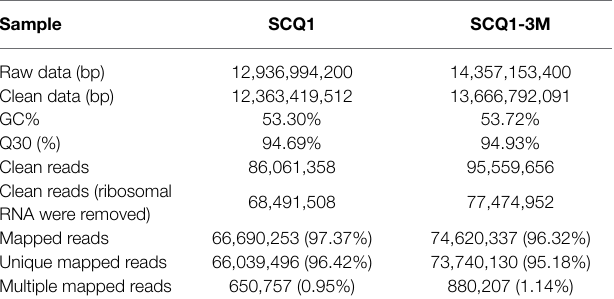
TABLE 1 | Summary of transcriptome sequencing for SCQ1 and SCQ1-3M. Sample